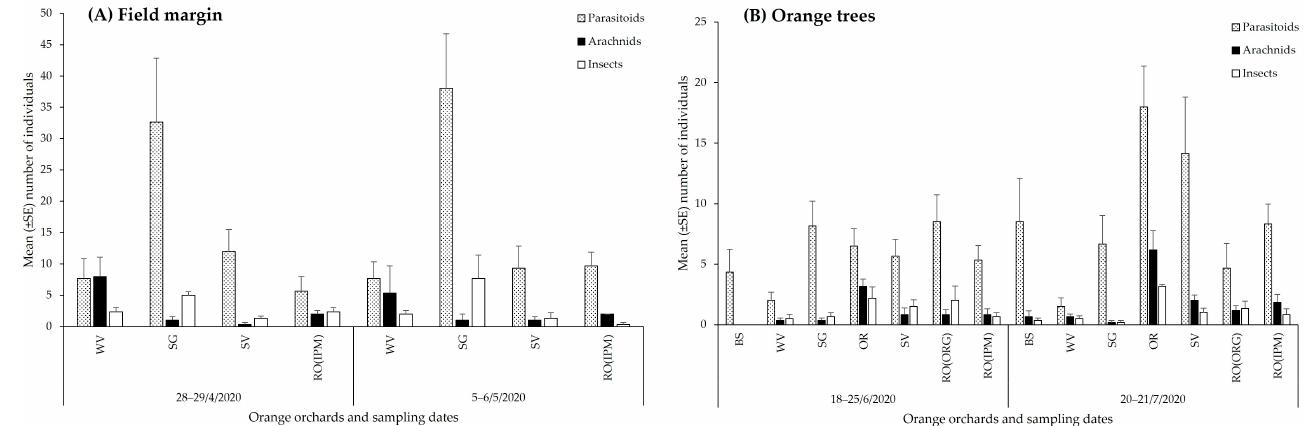
Figure 2. Temporal distribution of natural enemies (parasitoids, arachnid predators, and insect predators) ( A ) in field margins and ( B ) on orange trees at the baseline year (field margin management using the usual farmers’ practice).